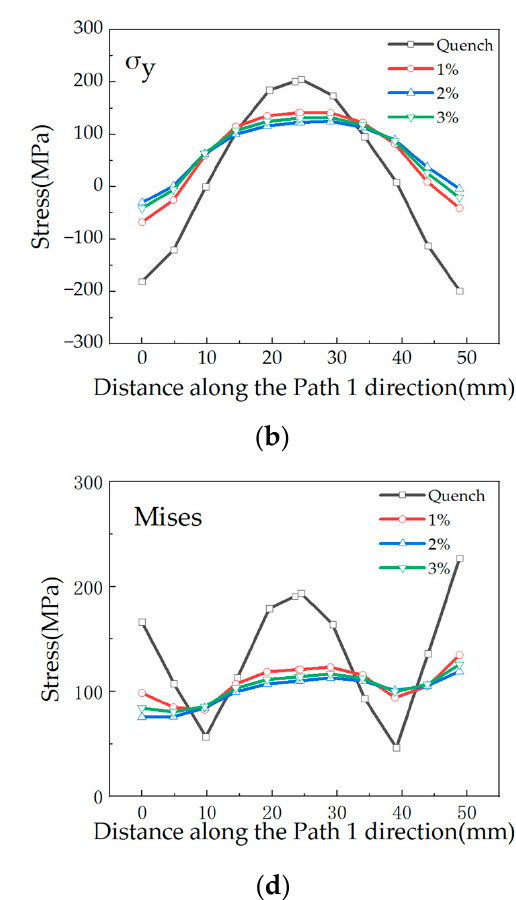
Figure 6. Effect of cold expansion ratio on quenched stress of the forging: ( a ) stress in X-direction; ( b ) stress in Y-direction; ( c ) stress in Z-direction; ( d ) von Mises stress.